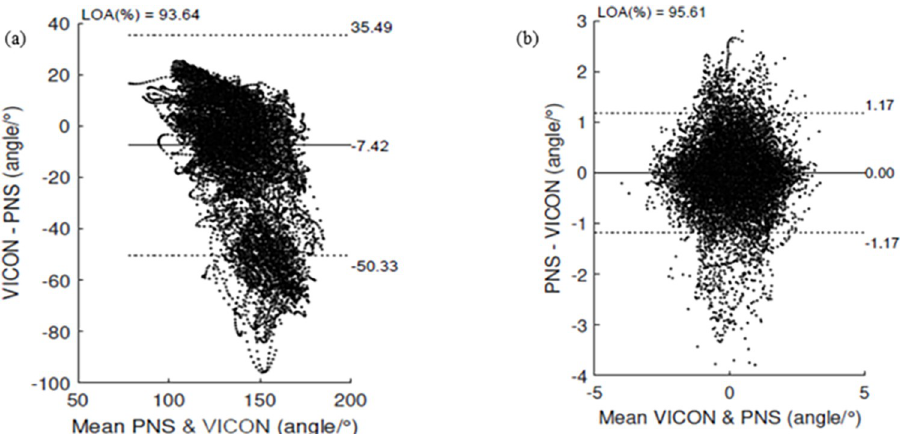
Fig 3. Bland-Altman plot of agreement for hip flexion/extension for distance wrist shot using (a) raw joint angles (b) normalized joint angles for all participants. Solid horizontal lines represent the mean difference and the dashed horizontal lines represents the 95% limits of agreement ( ± 1.96